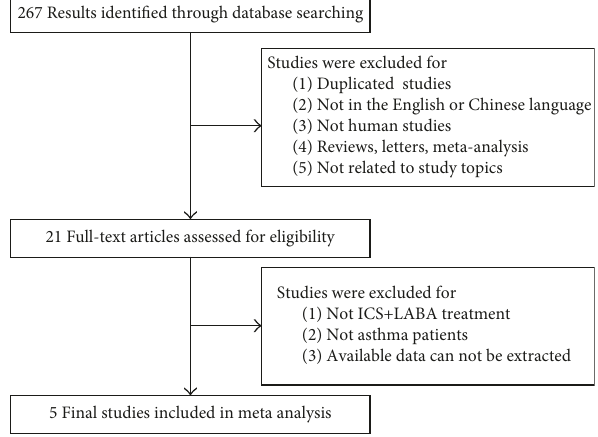
Figure 1: Flow chart of article